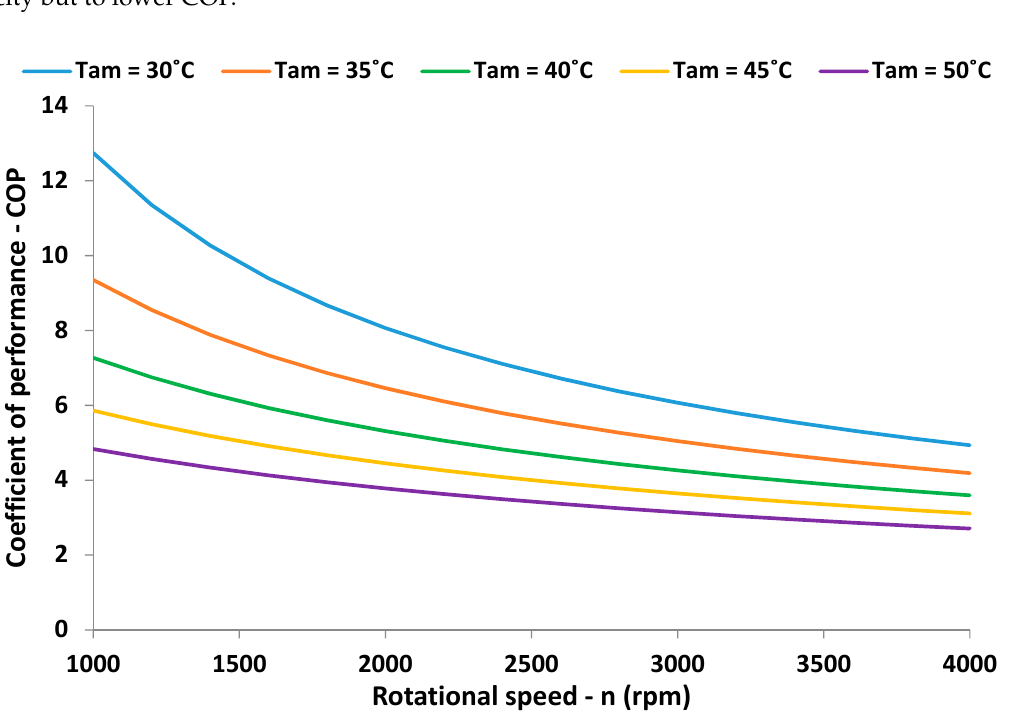
Figure 3. Cooling capacity for different rotational speeds and ambient temperatures ( T ind = 25 °C).